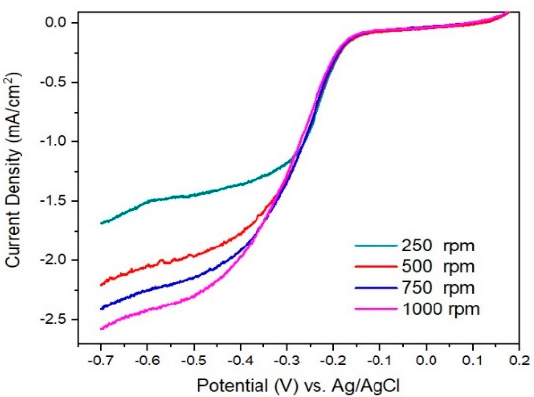
Materials 2022 , 15 , x FOR PEER REVIEW